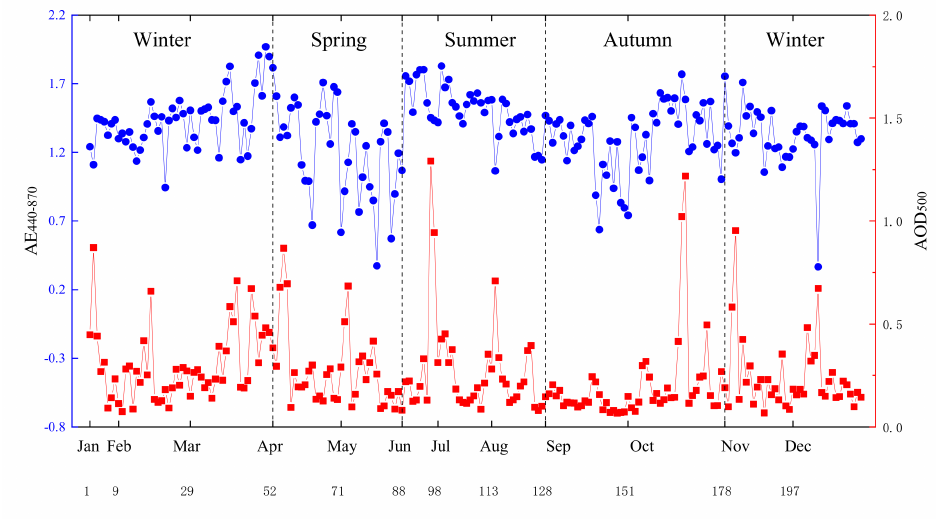
Figure 2. Daily variations in the aerosol optical depth at 500 nm and Angstrom exponent at 440–870 nm during the study period.